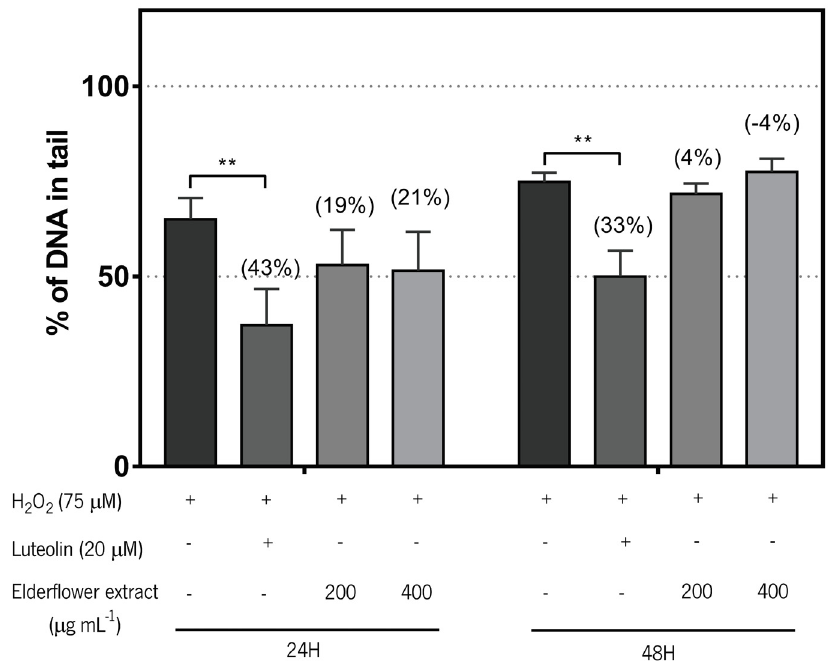
Figure 4. Effects of 24 and 48 h of pre-treatment with luteolin-7-glucoside (Luteolin, 20 µM) or S. nigra (elderflower) extract (200 and 400 µg mL − 1 ) on oxidative DNA damage induced by 75 µM H 2 O 2 (5 min, on ice) in RKO cells. [+]—compound present; [ - ]—compound absent; ()—percentage of protection regarding to the respective control. Results are expressed as mean ± SD, of at least three independent experiments. ** p < 0.01.